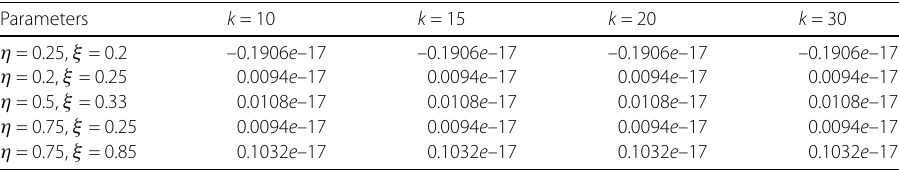
For different choices of η and ξ and different scale level k , the absolute difference in bound- ary conditions of u ( t ) is displayed in Table 1. In Table 2 the absolute difference in boundary conditions of v ( t ) are